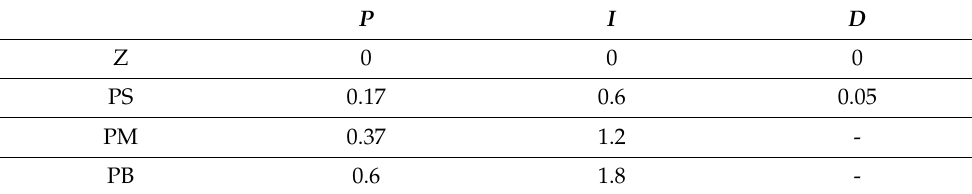
Table 2. The rule base of the fuzzy inference system. Inputs Outputs Linguistic Variable